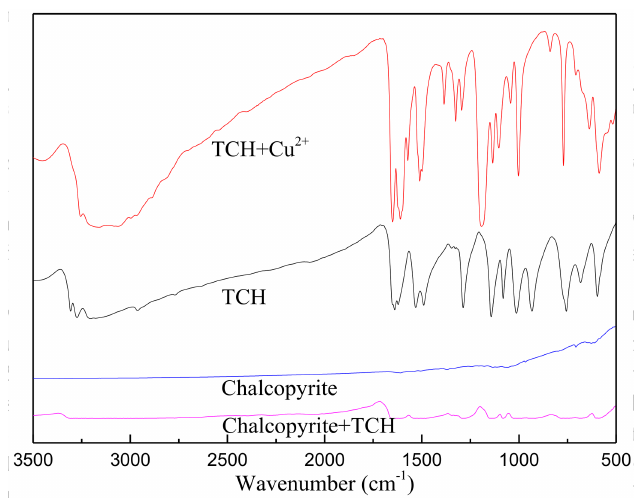
Figure 5. FTIR spectra of TCH, TCH–Cu 2+ complexes and chalcopyrite treated and untreated with TCH.